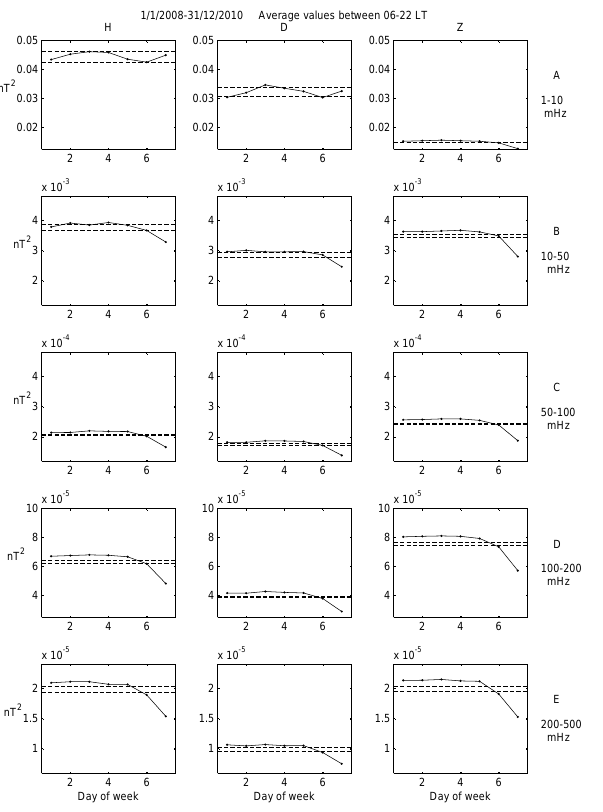
Figure 5. The traces of daily variation of the hourly-average power values for the entire week as evaluated for 2009 (blue line) com- pared with those for the whole period 2008–2010 for summer